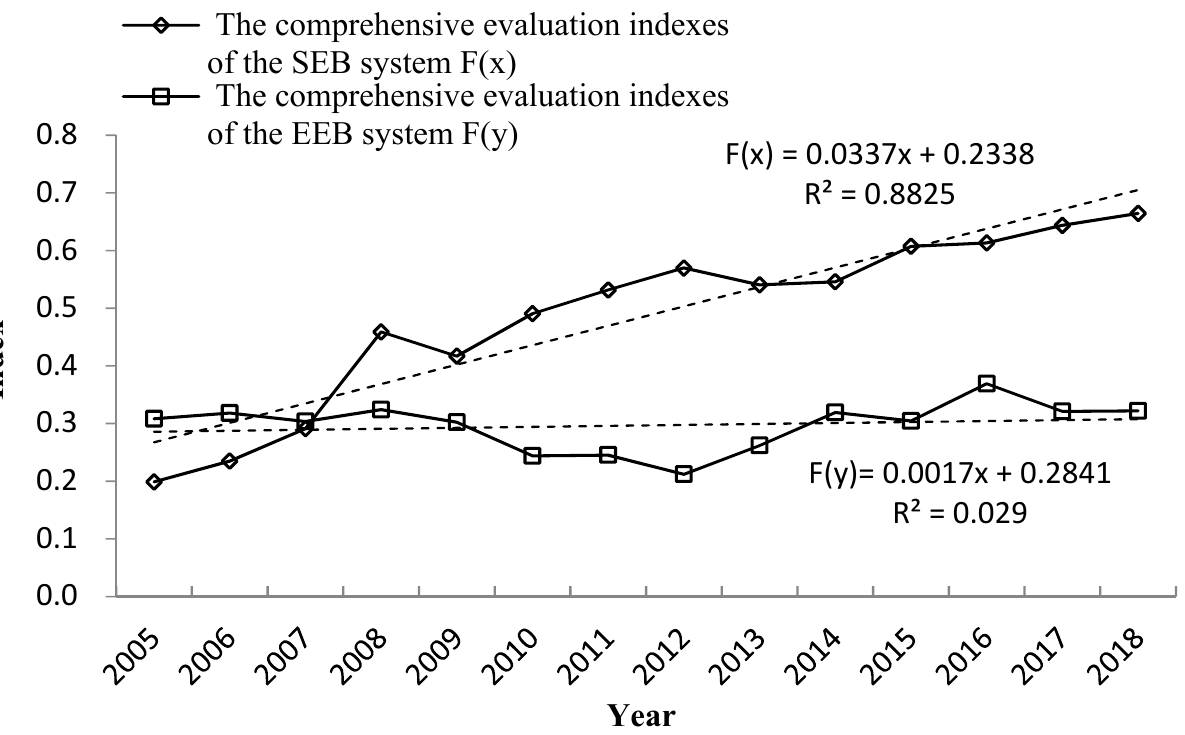
Figure 4. Evolution of comprehensive evaluation index of SEBs and EEBs of Koktokay Global Geopark from 2005 to 2018.